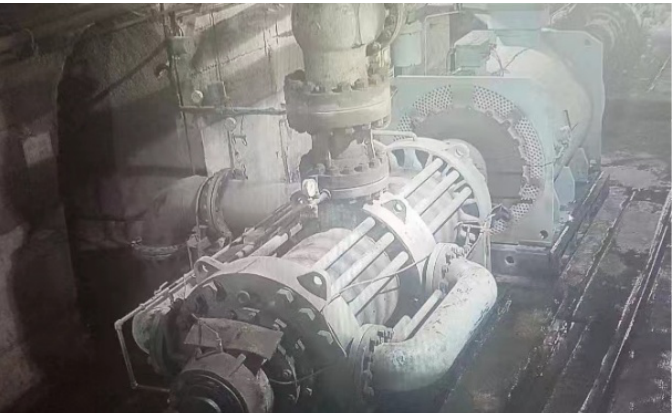
Figure 13. Several self-balancing multistage pump platforms.